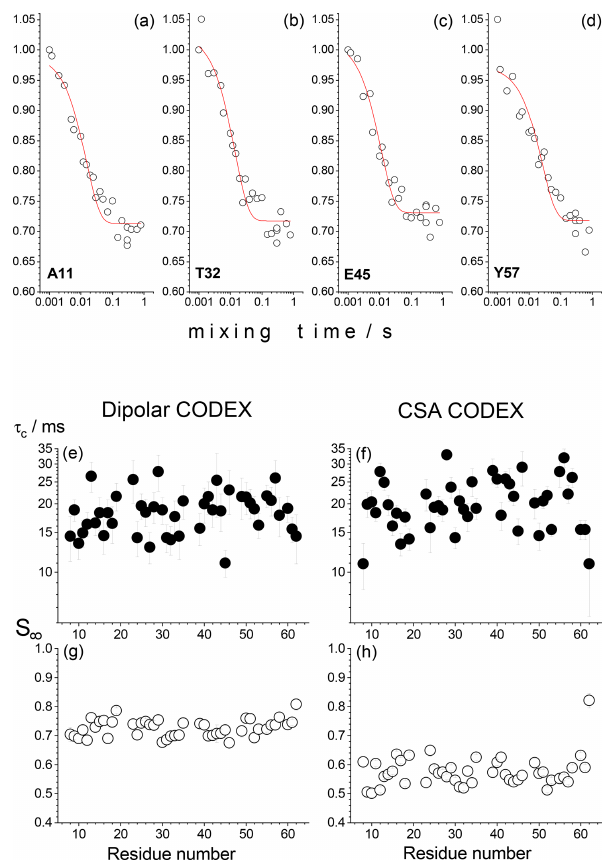
Figure 2. Results of the residue-resolved dipolar and CSA CODEX experiments in the SH3 protein microcrystalline sample at ambi- ent temperature, MAS 20kHz, NT R = 2ms. The mixing time de- pendences were measured for each resolved peak of the 2D 15 N– 1 H correlation spectrum. (a–d) Four examples of the mixing time decays (dipolar CODEX) of backbone 15 N’s are shown for the residues A11, T32, E45 and Y57. Red solid lines are the fits to the simple equation I ( τ m ) = I (0) ·[ (1 − S ∞ )exp( − τ m /τ c ) + S ∞ ] , where τ c is the apparent correlation time and S ∞ is the decay plateau at long τ m . (e–h) τ c and S ∞ for dipolar and CSA CODEX mixing time decays are shown as a function of the residue